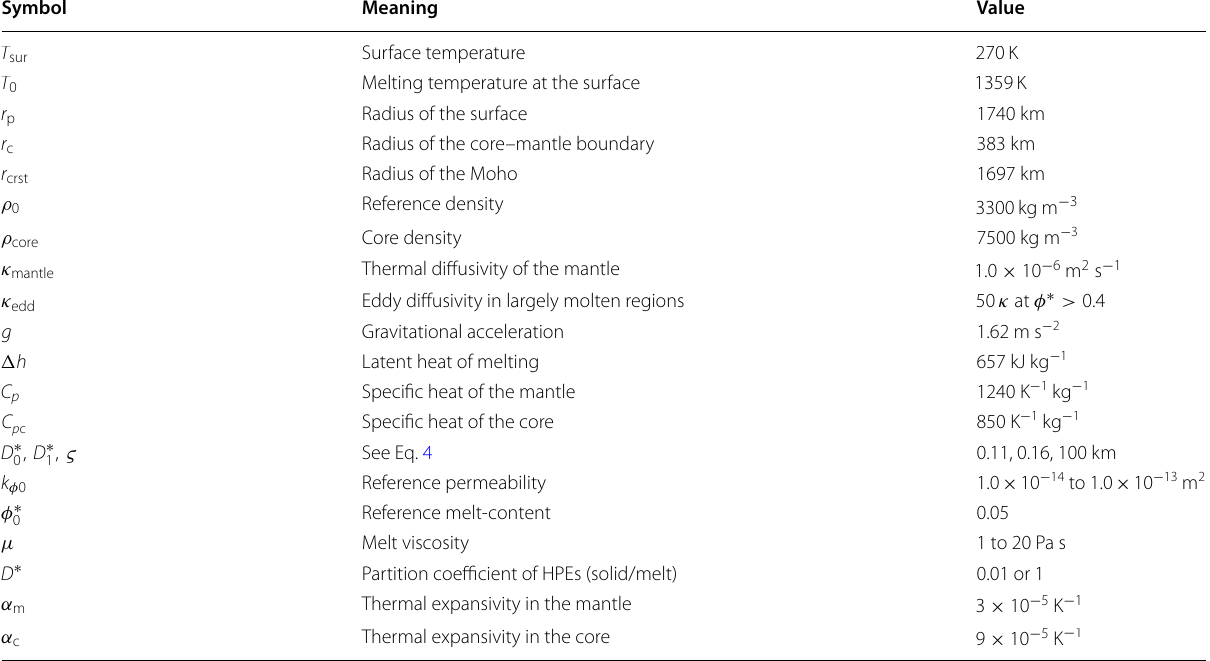
Table 1 The meanings of the symbols and their values Symbol Meaning Value T sur Surface temperature Melting temperature at the